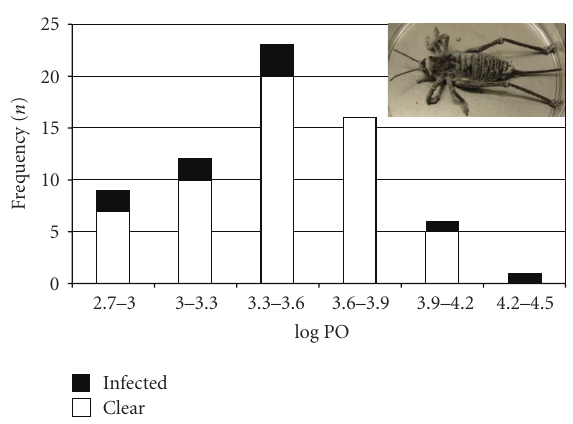
Figure 3: Phenoloxidase (PO) activity of survivors with fungal cells visible in their hemolymph (infected) and that of survivors with clear hemolymph. Inset: dark brown adult female Mormon cricket with white Beauveria sporulating on its